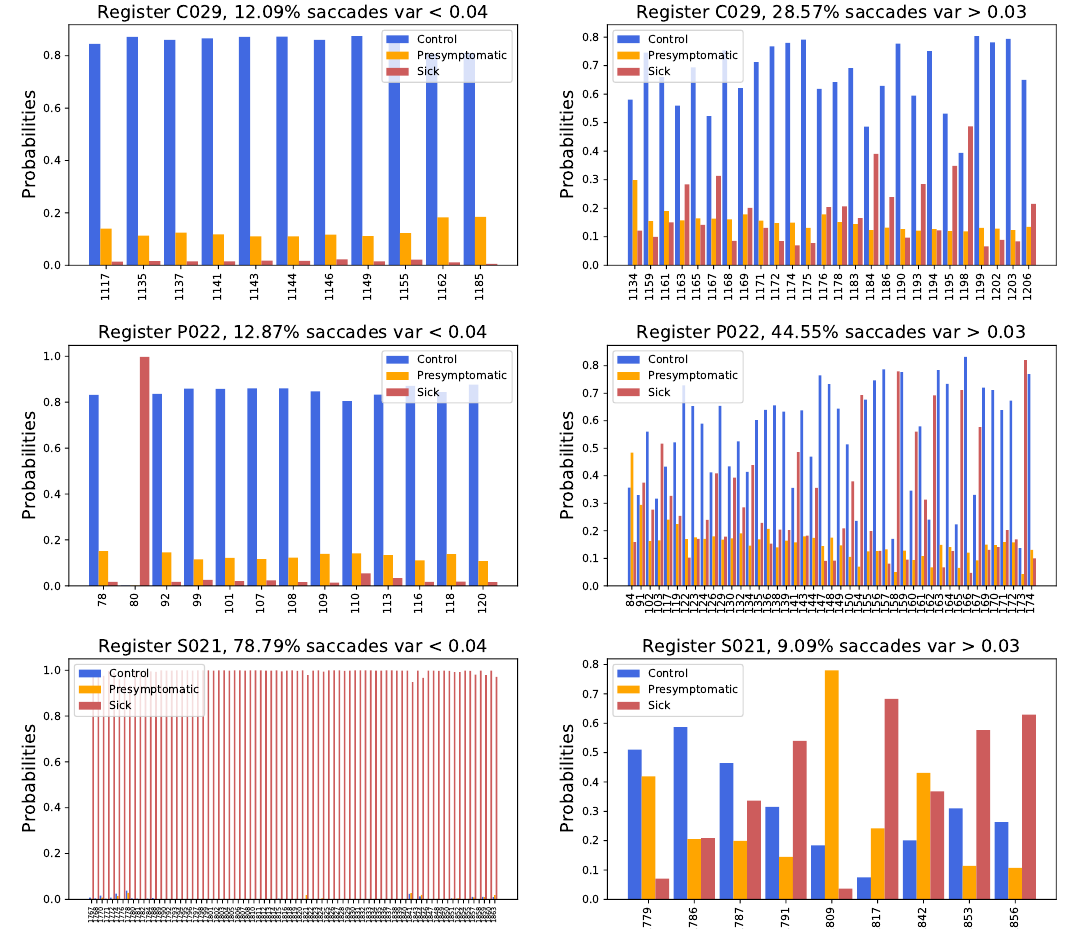
Figure 5. The label prediction with probabilities and variances for each saccade of the example registers as accumulated from the 100 MCD